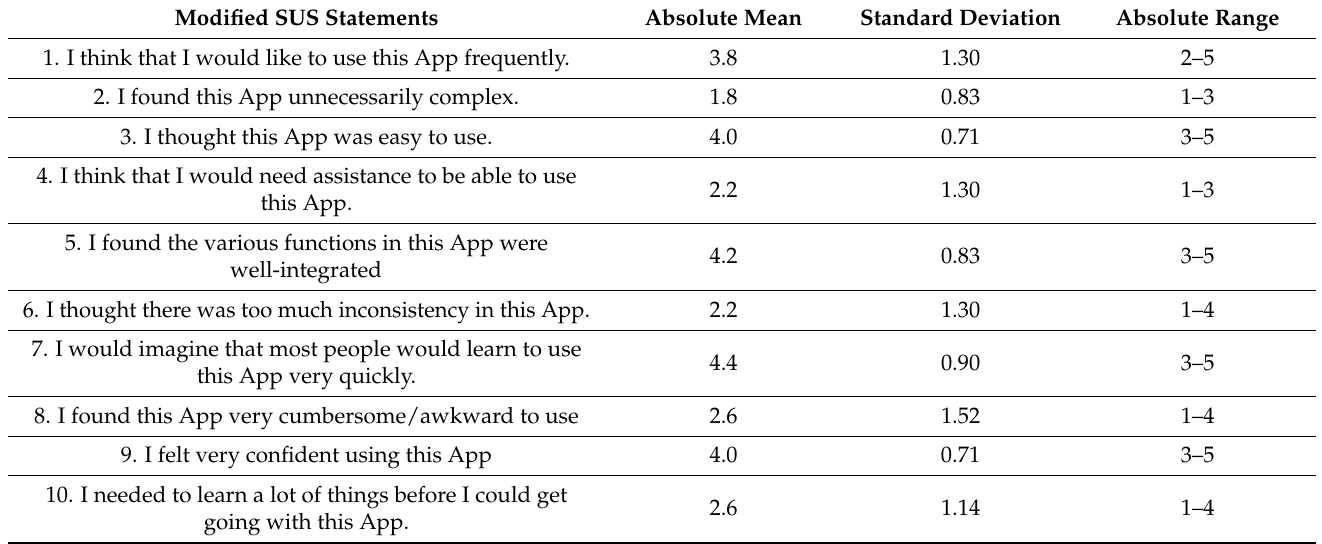
Table 3. Modified SUS statements and statistical score for each statement in terms of: “Absolute Mean”, “Standard Deviation” and “Absolute Range”. All measures (between 1 and 5) are based on the degree of agreement with the statement. 1 indicates strong disagreement while 5 indicates strong agreement with the